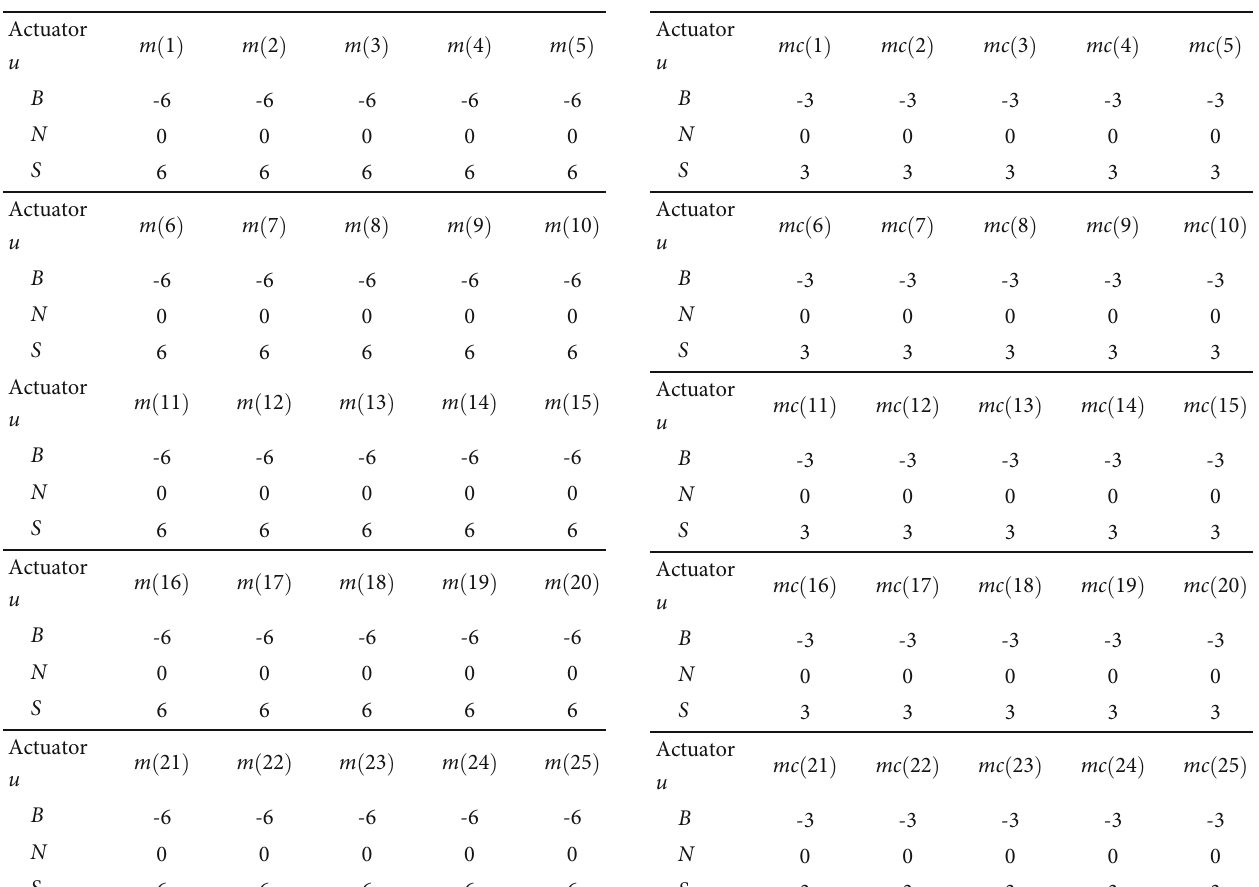
Table 5: Initial values of clustering centre m . Table 6: Initial values of the error change rate mc